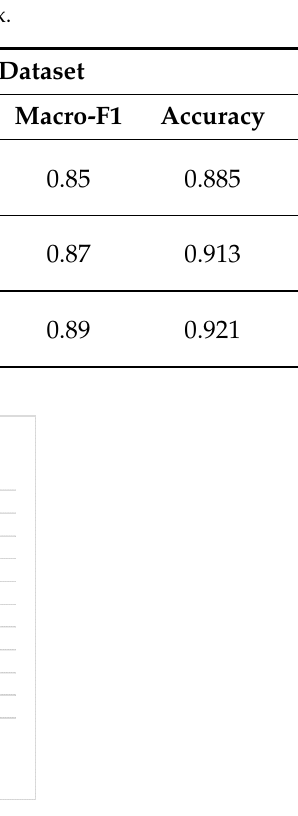
Figure 6. Plot of augmented dataset results (Experiment